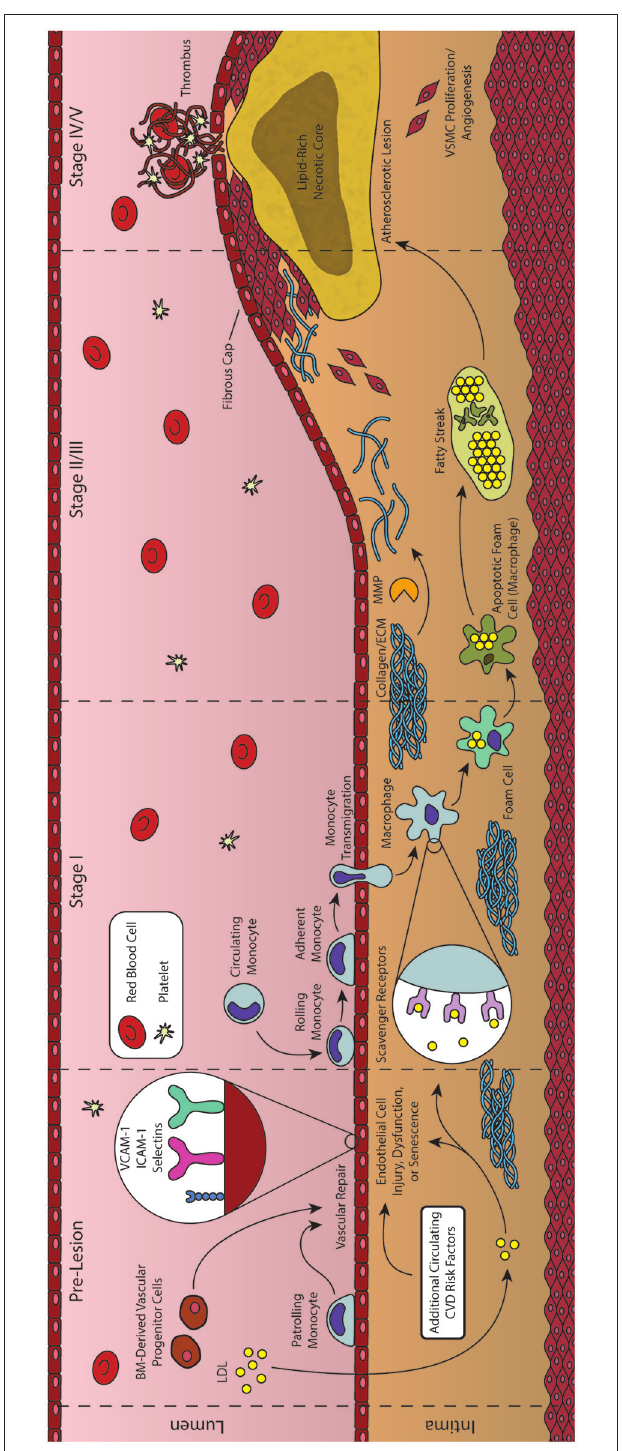
FIGURE 2 | Formation and progression of an atherosclerotic plaque. As an inflammatory disease, the initial stages of atherosclerosis involve an inflammatory insult to the endothelial cells lining the artery lumen. Bone marrow (BM)-derived progenitor cells have been shown to be critical in responding to vascular injury, effecting vascular repair and maintaining homeostasis. In the